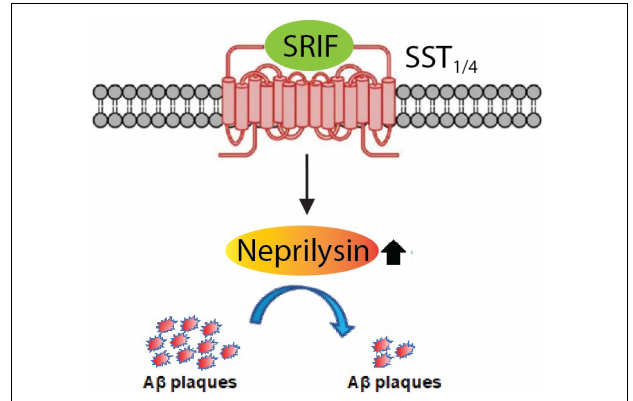
FIGURE 8 | Somatostatin receptor subtypes 1 and 4 (SST 1 / 4 ) regulate the A β -degrading enzyme NEP. The neuropeptide somatostatin (SRIF) was identified as a regulator of NEP activity through in vitro screening. Subsequent analysis of the effect of genetic deletion of somatostatin receptor (SST) subtypes in mice revealed that SST 1 and SST 4 regulate NEP in a redundant manner. This was further confirmed by concurrently deleting SST 1 and SST 4 in App KI mice, which aggravated the A β pathology. SST 1 / 4 can be either a combination of SST 1 and SST 4 homodimers or an SST 1 /SST 4